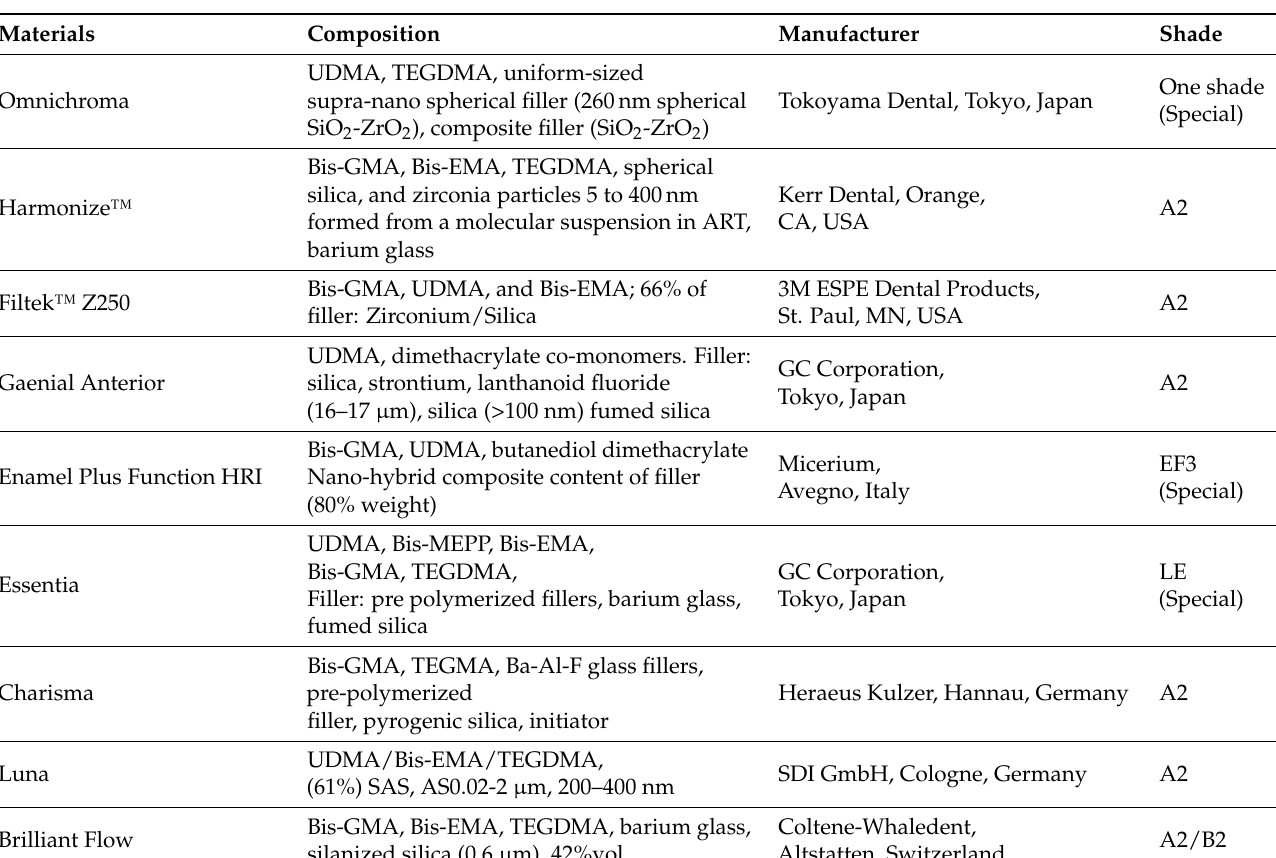
Table 1. Materials included in the